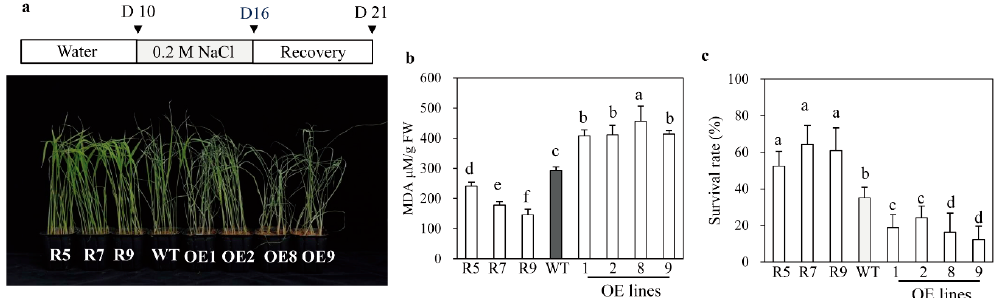
Figure 6. Response to salt treatment. ( a ) Rice seedlings after recovery from salt stress treatment. ( b ) MDA content. ( c ) Survival rates. Ten-day-old rice seedlings were immersed in 0.2 M NaCl solution for 6 days and then allowed to recover for 5 days. D denotes the time course day. Different letters indicate significant differences as determined by a post-hoc Tukey’s HSD test at p < 0.05. Int. J. Mol. Sci. 2019 , 20 , x FOR PEER REVIEW